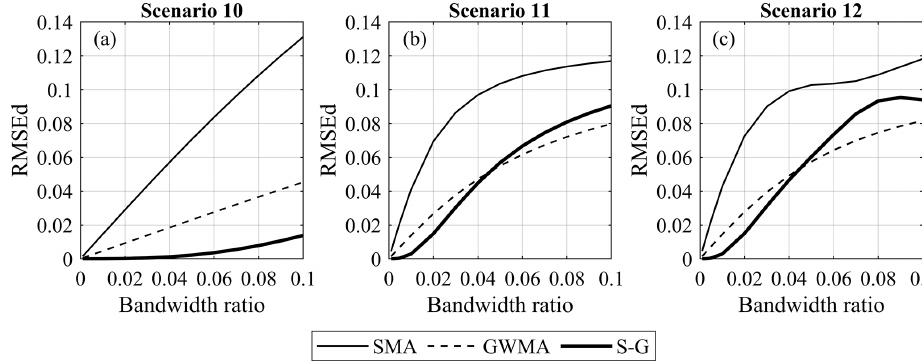
Figure 11. RMSEd for the instantaneous